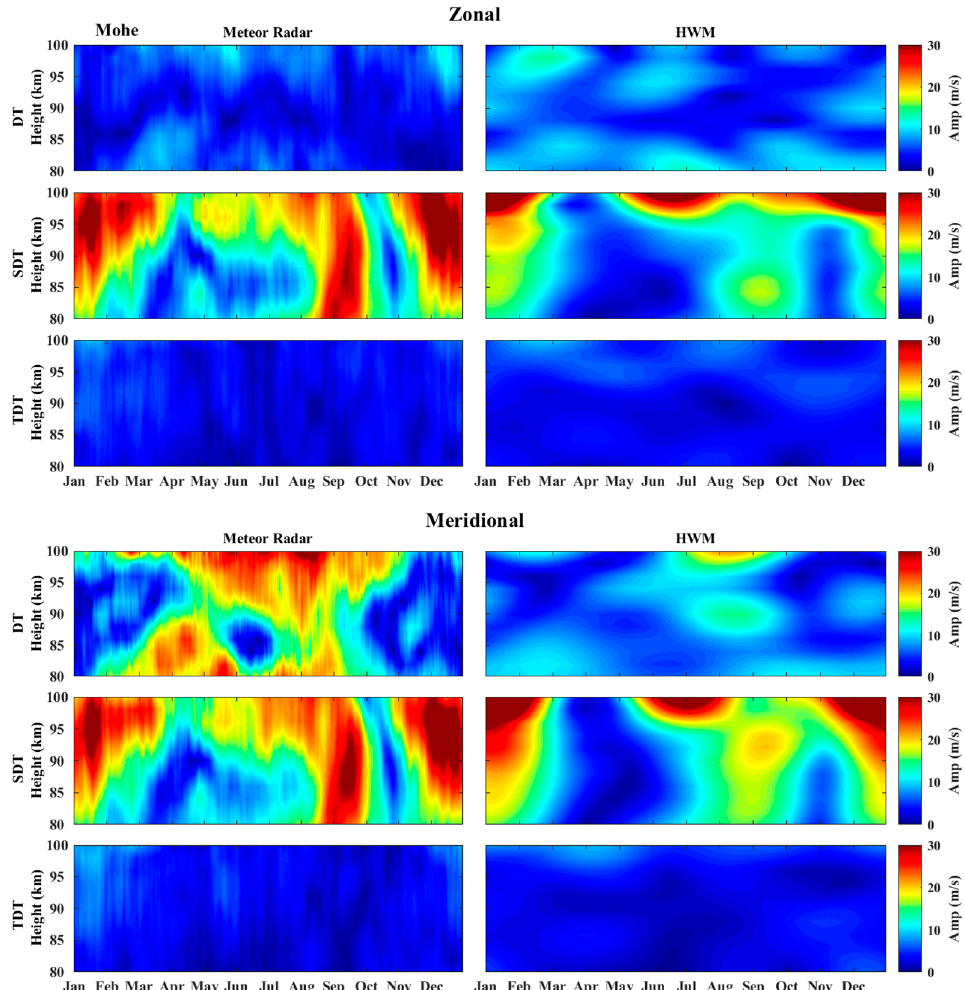
Figure 4. Diurnal (DT), semidiurnal (SDT), terdiurnal (TDT) tidal amplitude obtained from Mohe meteor radar measurements ( left column ) and HWM14 ( right column ).